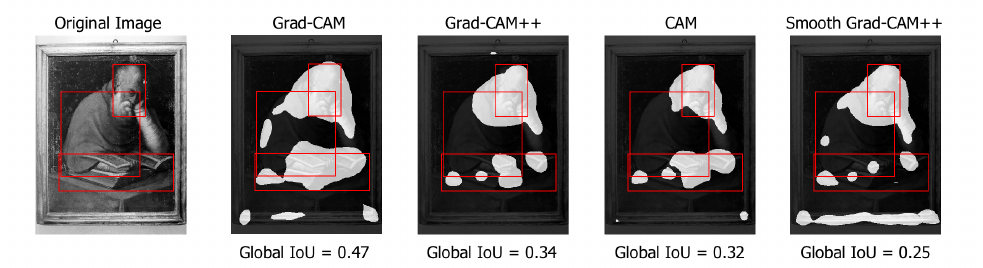
Figure 9. Different values of global IoU produced by different class activation map algorithms (Smooth Grad-CAM++ with σ = 1 and s = 5) at threshold t = 0.05. Manually annotated symbol bounding boxes are